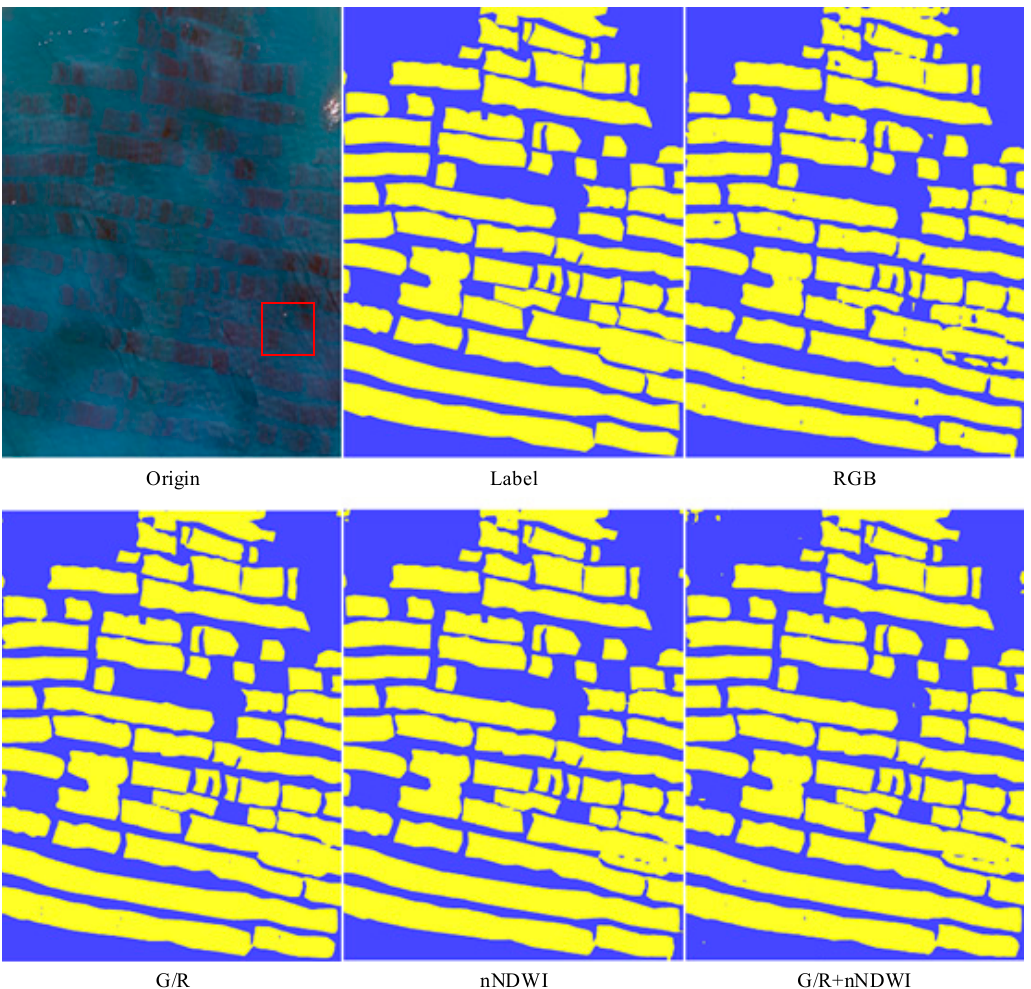
Figure 5. Classification results of di ff erent band characteristics under uniform distribution of strong and weak signals.